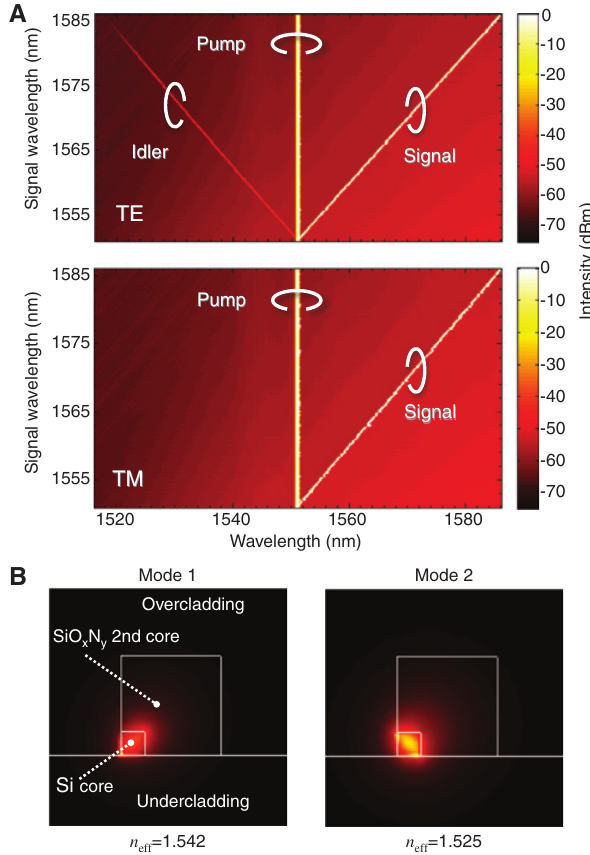
Figure 3: (A) Polarization dependence of the FWM efficiency in an SWW, investigated via stimulated FWM experiment. The density plots show the observed spectrum as a function of the center wavelength of the CW laser used for stimulating signal field. (B) The eigenmodes in the silicon polarization rotator, numerically simulated with a mode solver. Corresponding eigenvalues (effective refractive indices) are also shown. Figures from Ref.